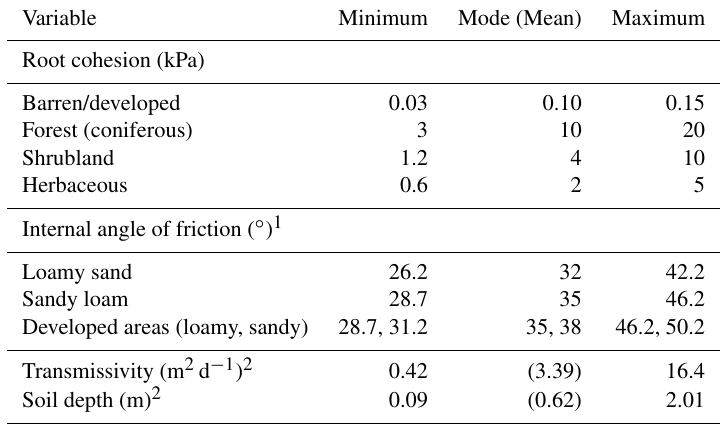
Table 1. Parameters defined for vegetation and soil types in the study region. For spatially continuous variables T and h s obtained directly from SSURGO, values represent spatial statistics.